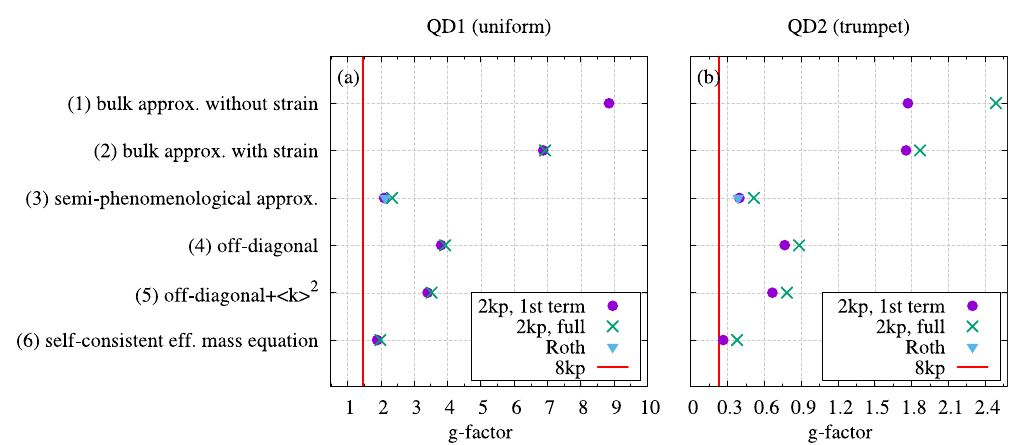
Figure 2. Ground state Landé factor for the sequence of approximations. Dots and crosses are defined as in Fig. 1. The triangle shows the result from the effective Roth formula. The red line shows the value obtained from the 8-band k · p